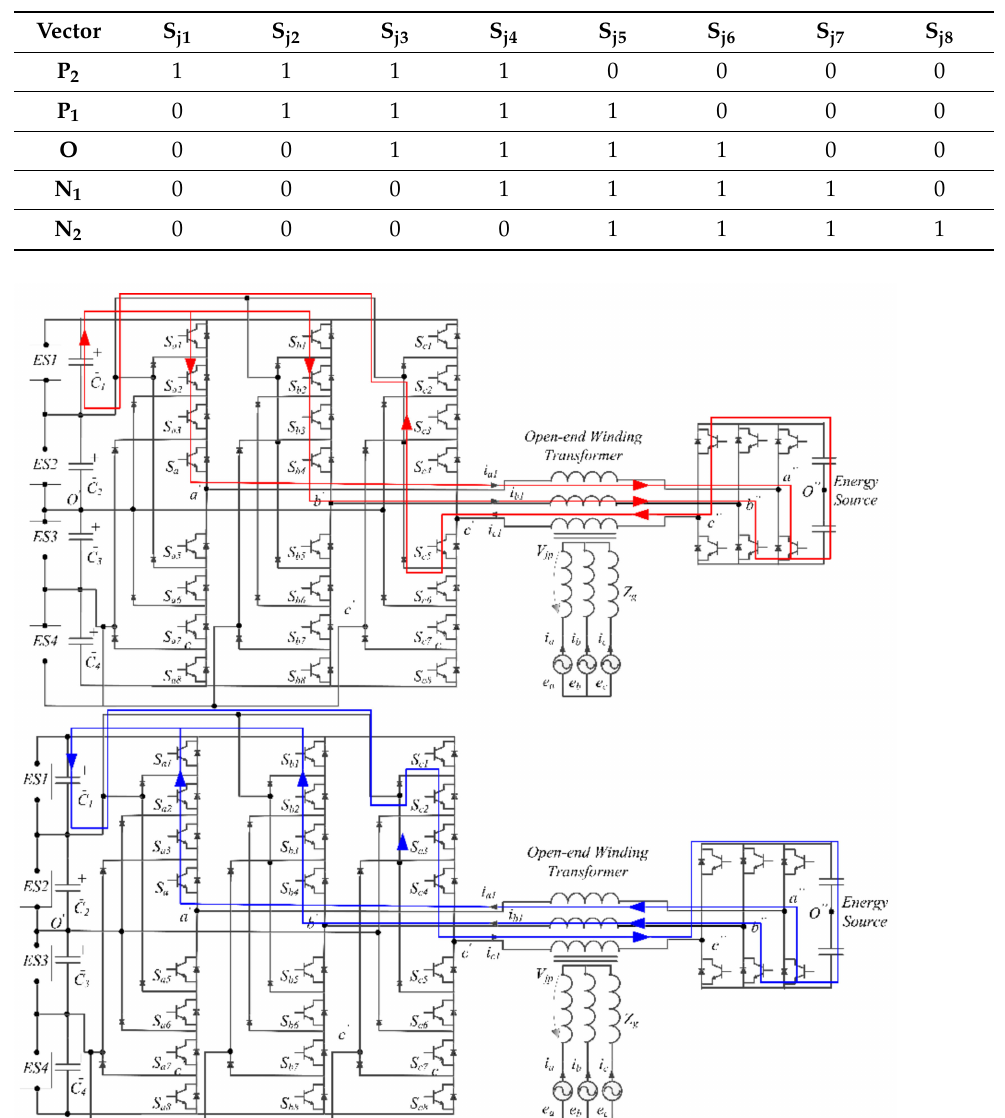
Table 3. Five-level NPC j-leg states.